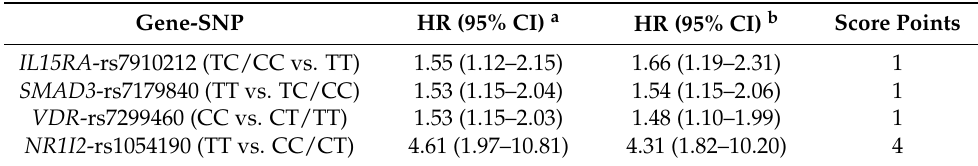
Table 3. Construction of a prognostic score for overall survival using selected polymorphisms (SNPs) in the combined case series of 320 patients with available